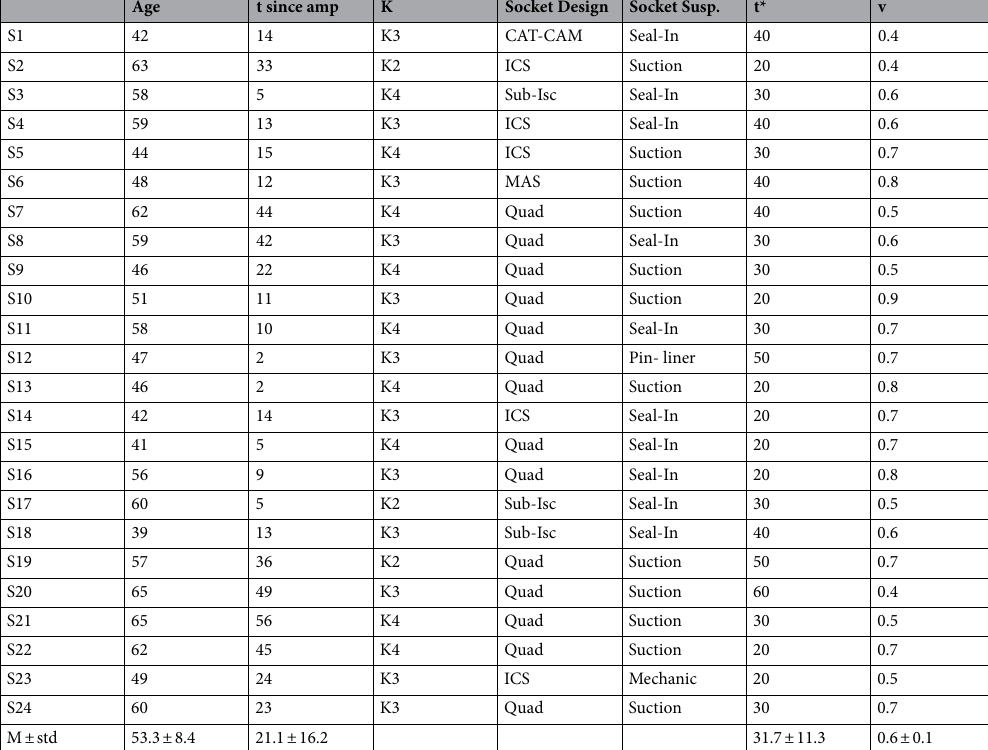
Table 2. Subjects’ general features, time required to stabilize the residual limb volume, t* [min], and self- selected speed on the treadmill, v [m/s]. S subject; age and t since amputation in years, K K level, rating system used to indicate the individual’s potential functional ability, K2 activities typical of limited community ambulatory, K3 activities typical of community ambulatory, K4 high-impact activities, CAT-CAM Contoured Adducted Trochanteric-Controlled Alignment Method, ICS Ischial Containment Socket, Sub-Isc Sub-Ischial, MAS Marlo Anatomical Socket, Quad Quadrilateral, M mean.